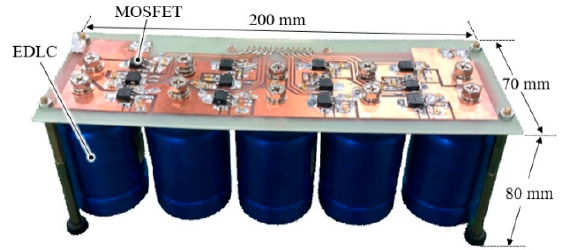
Figure 13. Prototype of series-parallel reconfiguration circuit for five EDLC cells.